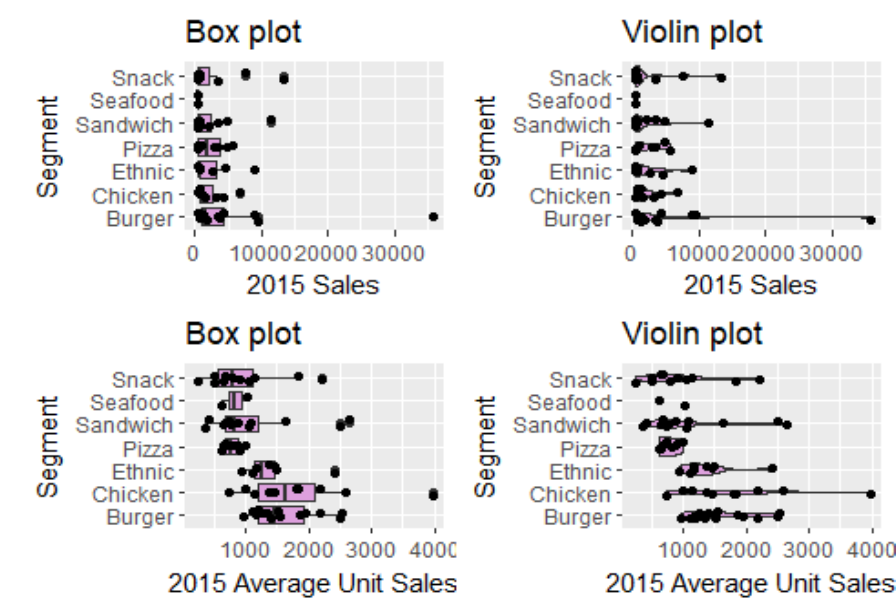
Fig. 3. QSR boxplots and violin plots by